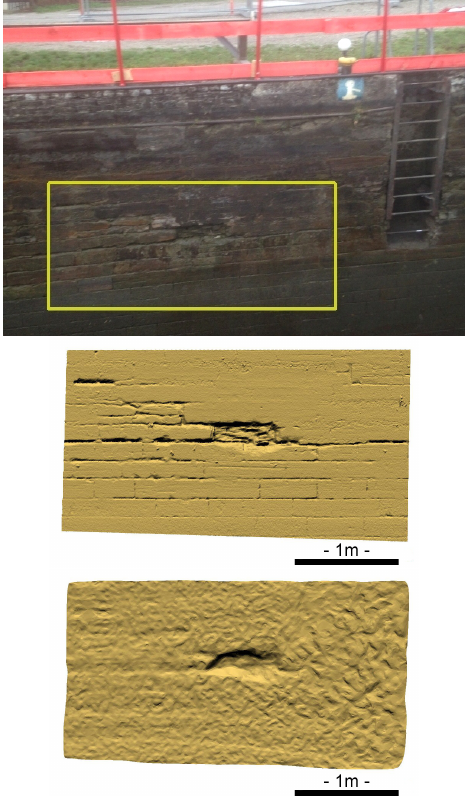
Figure 12. Front views of a piece of sidewall obtained from TLS (top) and MSS (bottom) scans taken upside-down from the water surface.